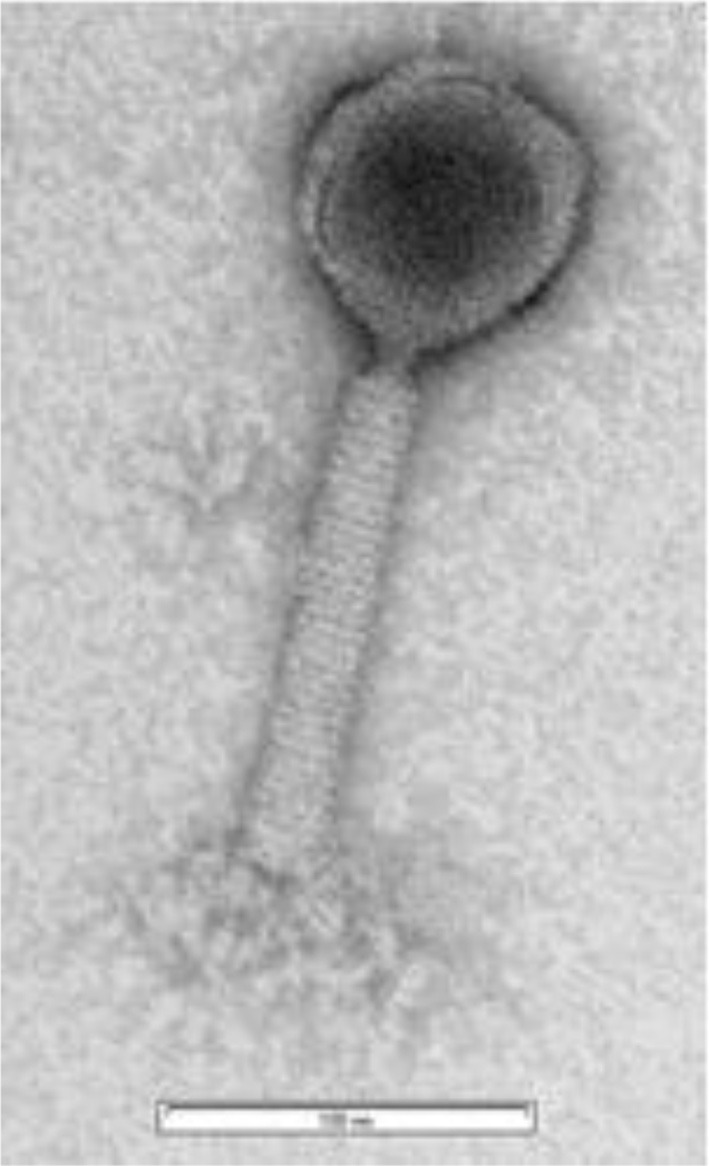
Transmission electronmicroscopic image of phage ZCKP1.